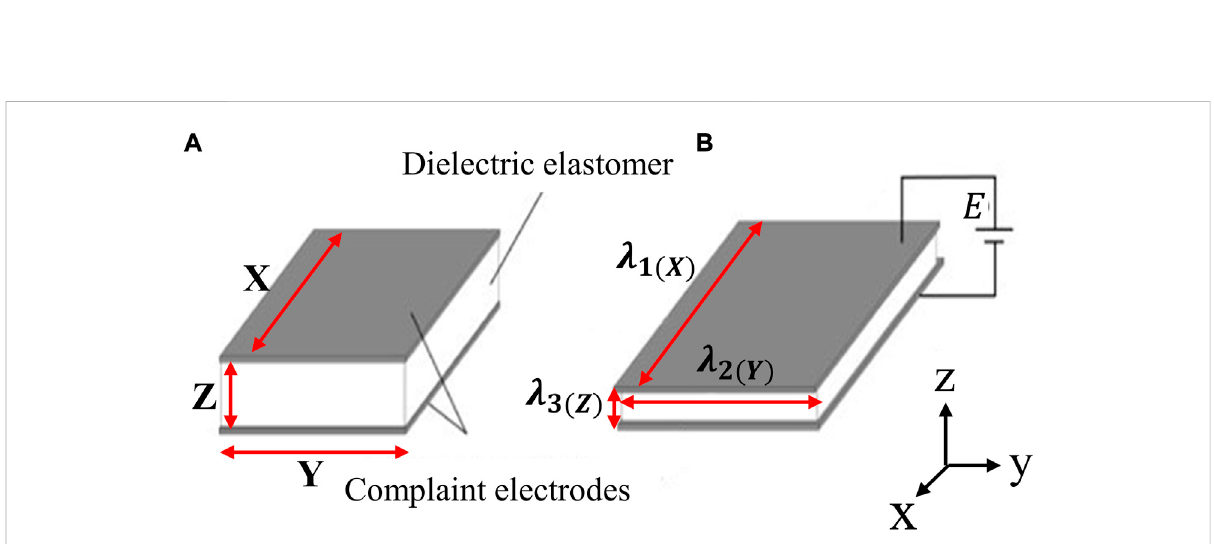
FIGURE 2 Optimization of the DE actuator for